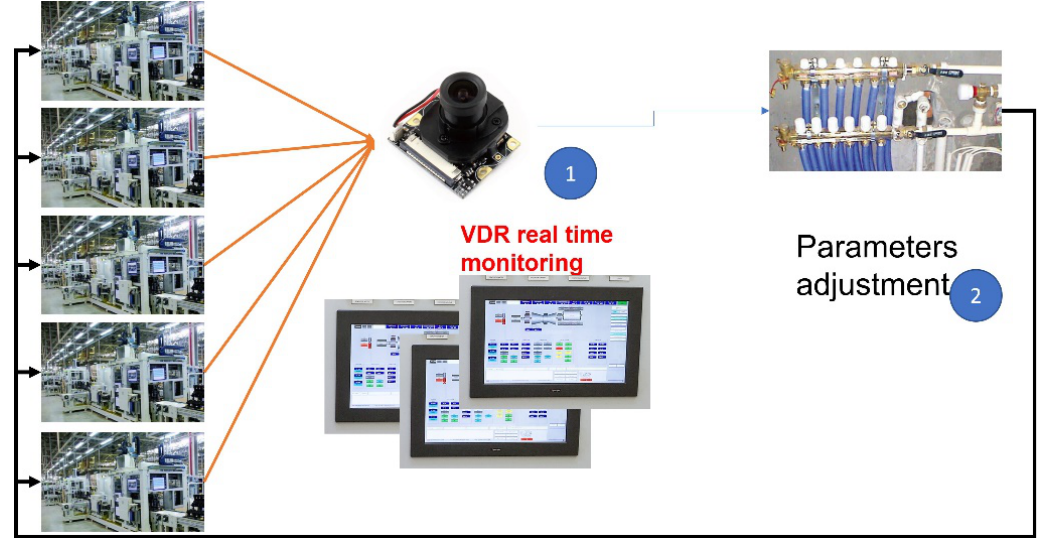
Figure 7. The proposed condition monitoring by the VDR system.